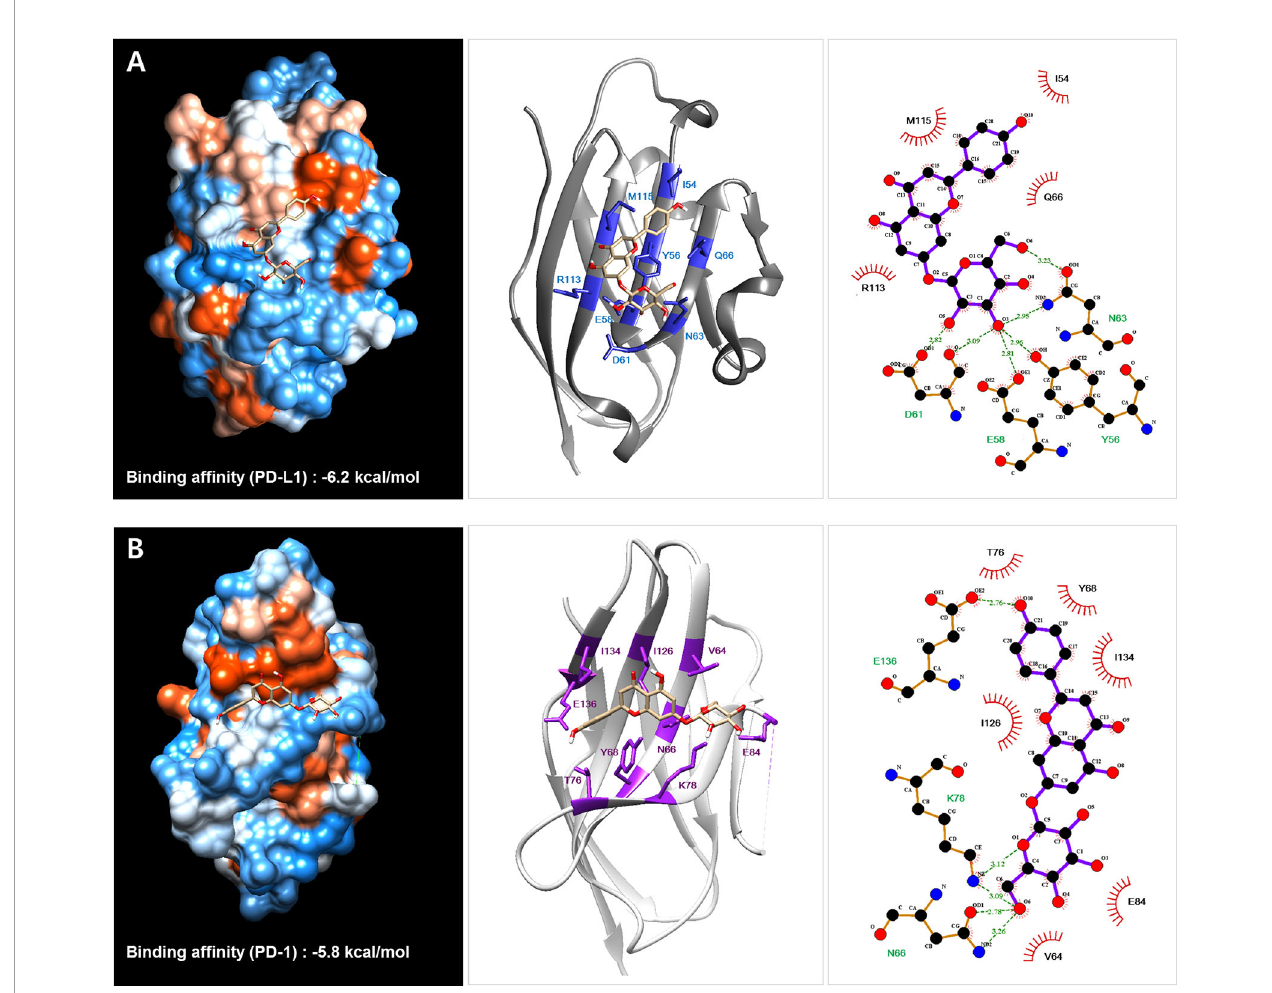
FIGURE 5 | Protein – ligand docking simulation between PD-L1 (A) /PD-1 (B) and the Salvia plebeia R. Br. ethanol extract (SPE) component cosmosiin. Binding models were obtained through docking simulation of cosmosiin on PD-L1 and PD-1 derived from the PD-1/PD-L1 complex (PDB code 4ZQK) using AutoDock Vina. The hydrogen bonds and hydrophobic interactions between PD-L1/PD-1 and cosmosiin were analyzed using